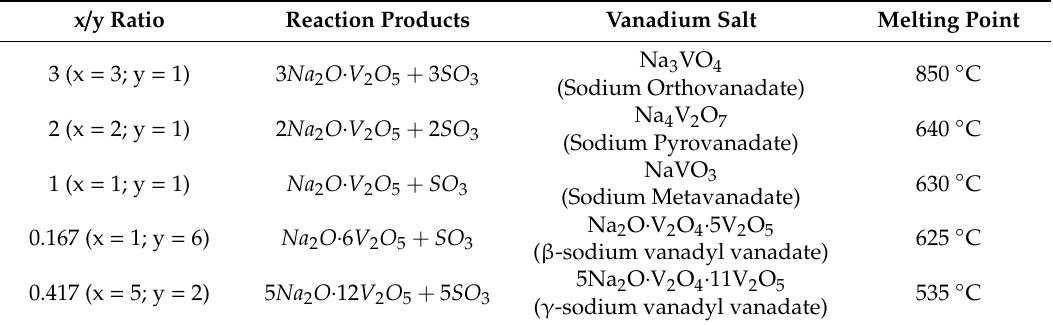
Table 1. Main vanadium compounds formed according to Equation